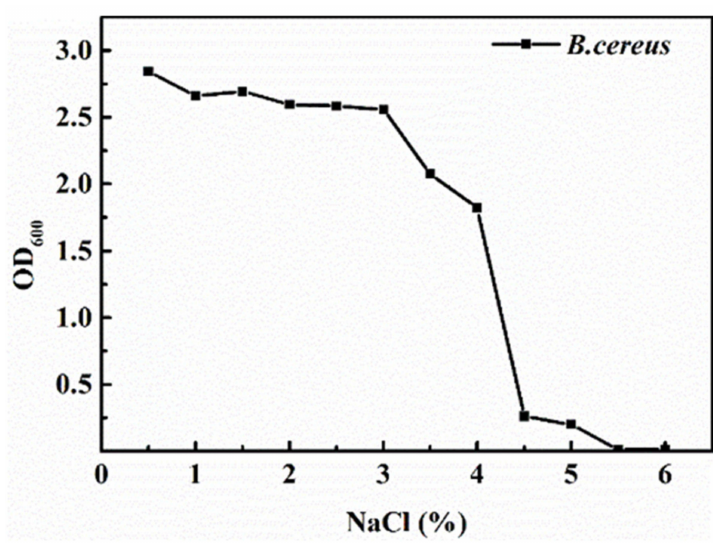
Figure 1. Survival of B. cereus in media with different NaCl